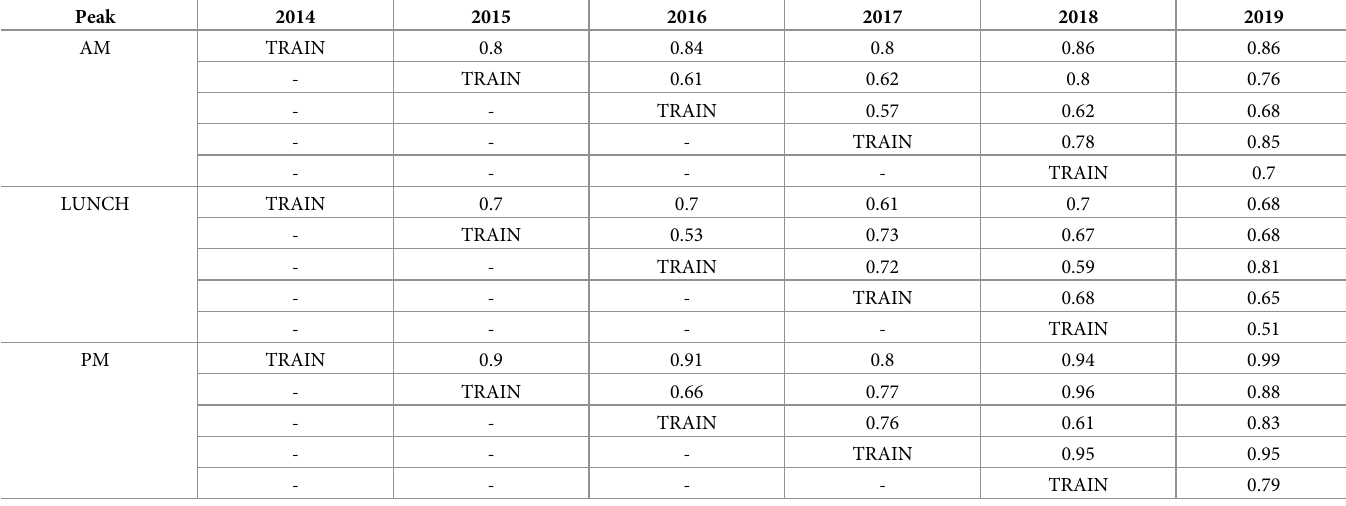
Table 5. Examining stability of model prediction performance without sensor-level dummies over time (using RMSE).